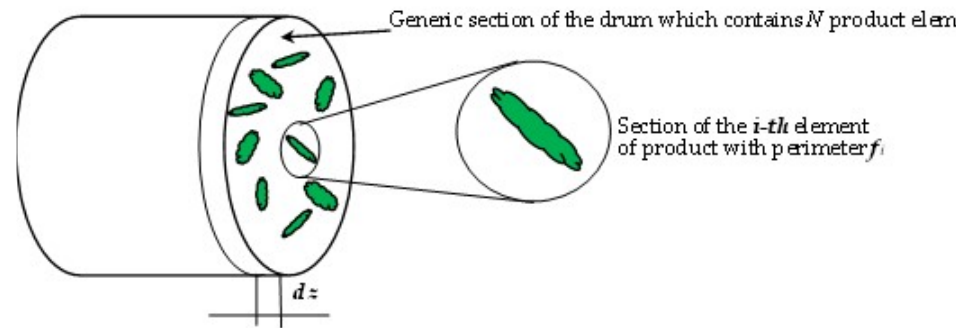
Figure 3. Generic section of the drum containing N product elements. In the foreground, the i th ele- ment with perimeter f i is shown. The average value of the sum of the perimeters f i of all elements in the generic drum section constitutes the “transverse dimension,” 𝑓 = ∑ 𝑓 (cid:3036) , (cid:3015) (cid:3036)(cid:2880)(cid:2869) which is multiplied by the infinitesimal axial length dz to give the elemental area dA = f·dz .